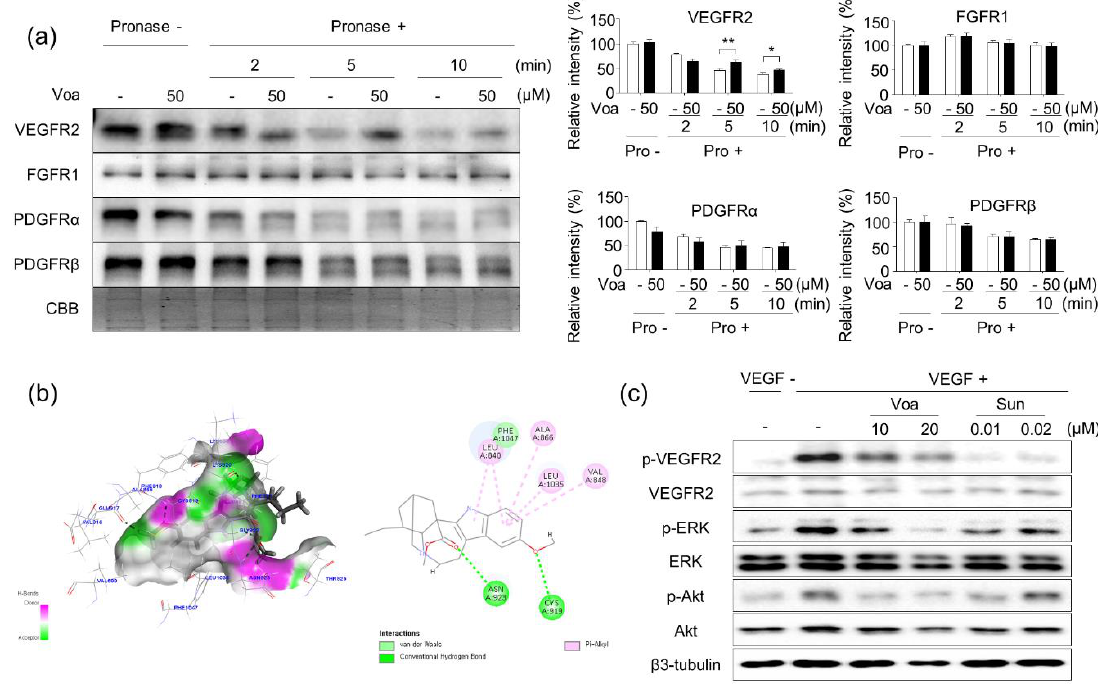
Figure 3. Voacangine specifically and directly binds to vascular endothelial growth factor receptor 2 (VEGFR2) ( a ) DARTS results from direct binding of voacangine to various receptor tyrosine kinases (RTKs) in HUVECs. HUVEC lysates were incubated with voacangine and digested with pronase (1 μg/mL) at each incubation time. Each value represents the mean ± S.D. from three independent experiments. ** p < 0.01 versus control, * p < 0.05 versus control. NT: non-treated control, Voa: voacangine-treated, Pro -:Pronase non-treated; Pro +:Pronase treated; -:Non-treated ( b ) In silico docking analysis using a 2D-diagram for validating the interaction between voacangine and VEGFR2 (juxtamembrane and kinase domains, RCSB Protein Data Bank number: 4AGD). Left panel, green (voacangine) is superimposed with VEGFR2 (grey). Right panel, binding motifs are illustrated with various interactions of voacangine with the ATP-binding pocket of VEGFR2. ( c ) Effect of voacangine on VEGF-induced VEGFR2 signaling. Protein levels were determined by immunoblotting using specific antibodies. The results shown are representative of three independent experiments. Voa: voacangine-treated; Sun: sunitinib-treated.